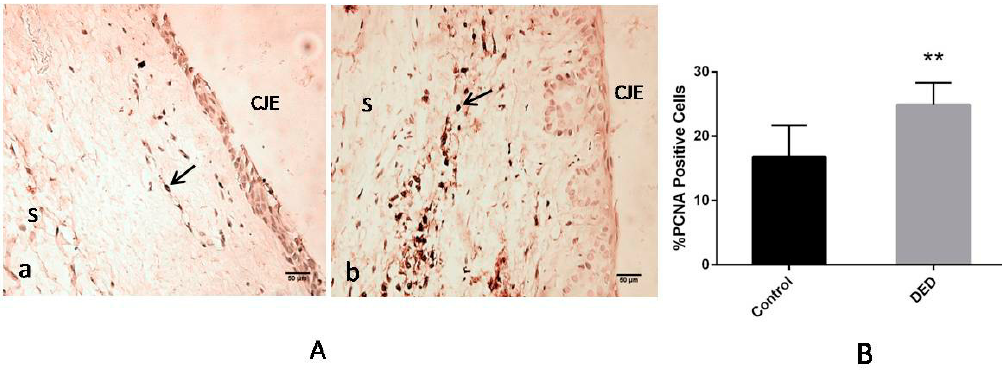
Figure 10. Proliferating cell nuclear antigen (PCNA) expression in the filtration blebs on day 28. ( A ) The control group ( a ) displayed reduced PCNA expression compared with that in the DED group ( b ) (400 × ); ( B ) the percentages of PCNA-positive cells in two groups were significantly different. Black arrows: PCNA-positive cells. CJE: conjunctival epithelium; S: sclera. ** p < 0.01. Scale bar = 50 µ m.